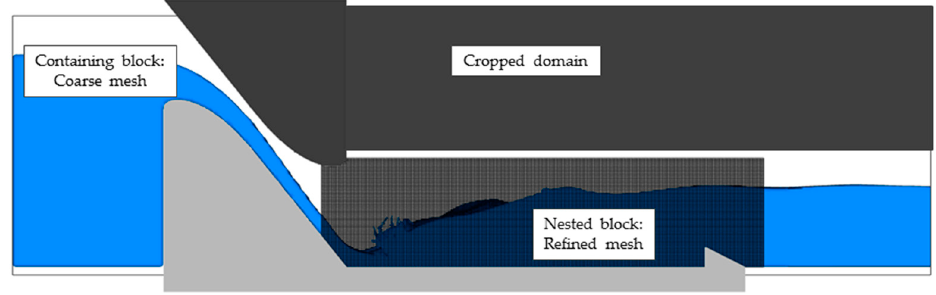
Figure 2. Meshed domain and detail of the containing and the nested mesh blocks.